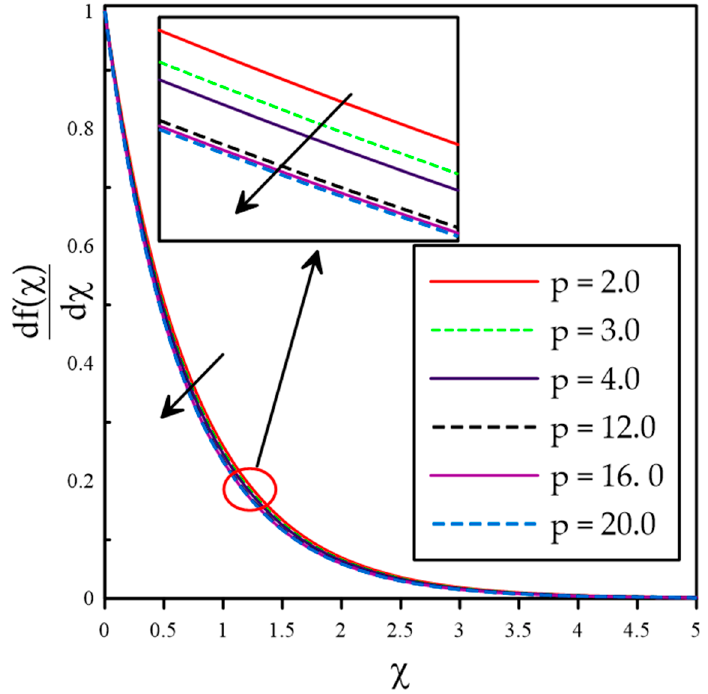
ξ= . Figure 4. Velocity profile against the various values of velocity index parameter when ξ =